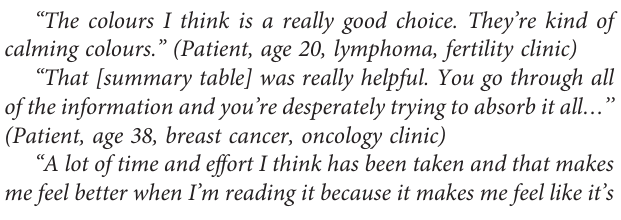
Results: Mean (SD)